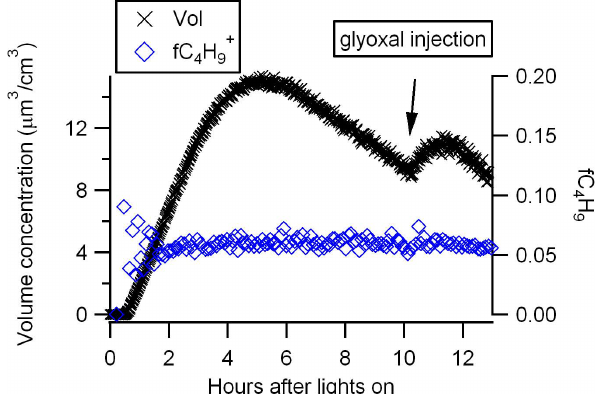
Fig. 9. The time traces of particle volume formed from 2-tert- butylphenol photooxidation and C 4 H + fragment in particles (Run 9 1489A). Particle volume increased immediately after glyoxal injec- in organics was unaffected, indi- tion while the fraction of C 4 H + 9 cating the increase of particle volume was due to enhanced reaction of 2-tert-butylphenol, as opposed to glyoxal